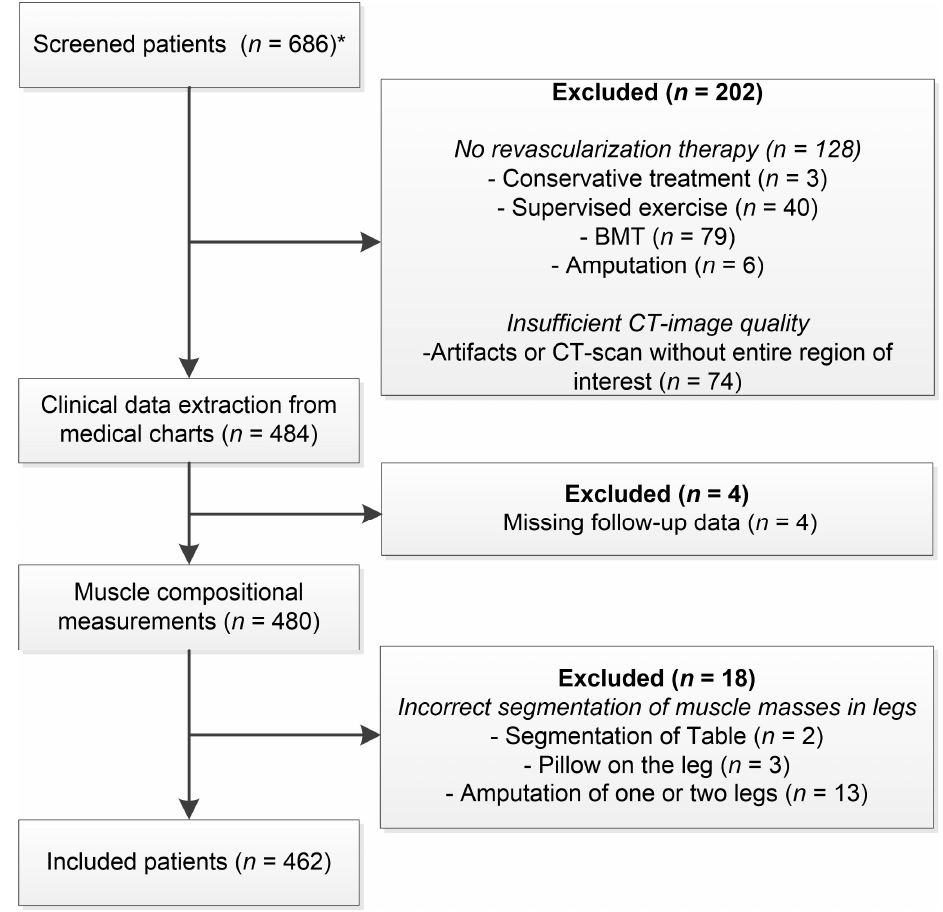
Figure 1. Workflow and selection process of included patients. (BMT) = best medical treatment, CT = computed tomography, * Patients screened for eligibility were retrieved from an existing dataset [8].